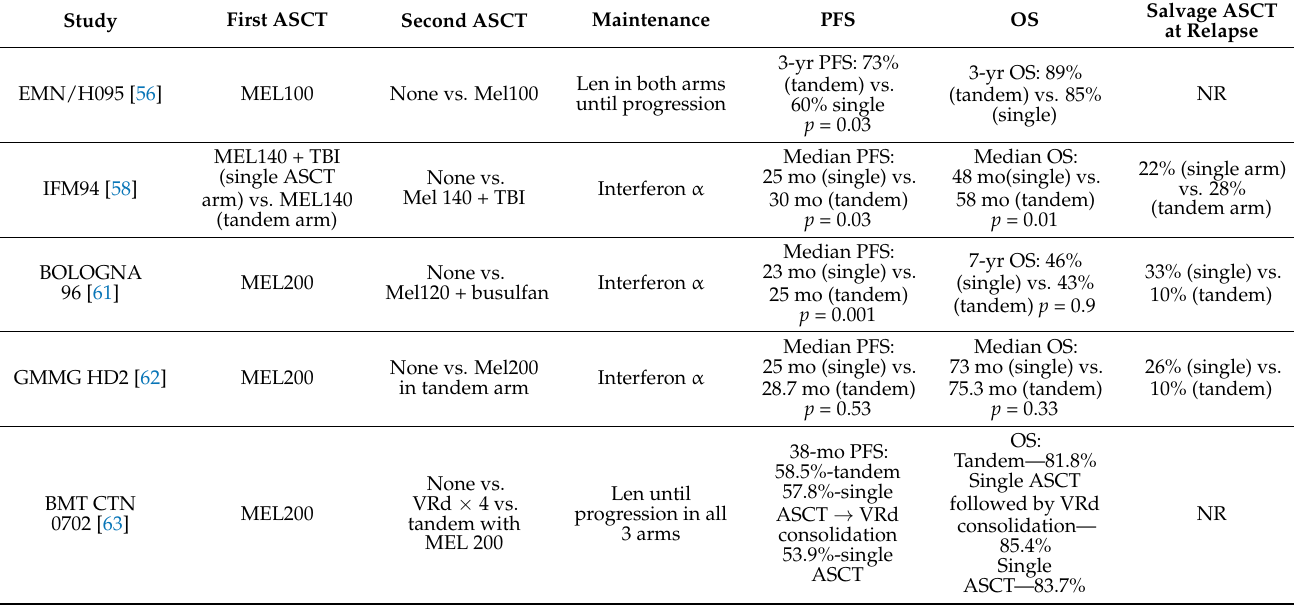
Table 2. Summary of randomized controlled trials comparing single versus tandem ASCT in